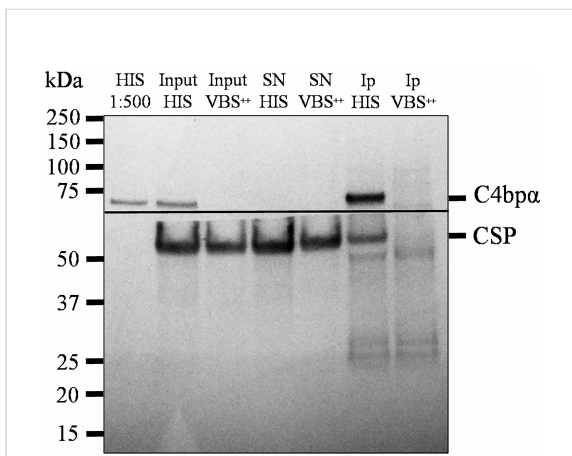
FIGURE 5 Native CSP from SPZs interacts with C4bp. SPZs were incubated with either HIS or VBS ++ . SPZs were then thoroughly washed and lysed with a lysis buffer. C4bp bound to SPZ surface proteins was immunoprecipitated from the lysate using anti-C4bp and immunoprecipitated proteins were subjected to SDS-PAGE under reducing conditions and Western blotting. The horizontal line represents the membrane separation point for the membrane pieces probed with anti-C4bp (upper piece) and anti- CSP antibodies (lower piece). HIS: heat inactivated serum; Input: starting material; SN: supernatant; IP: immunoprecipitates.